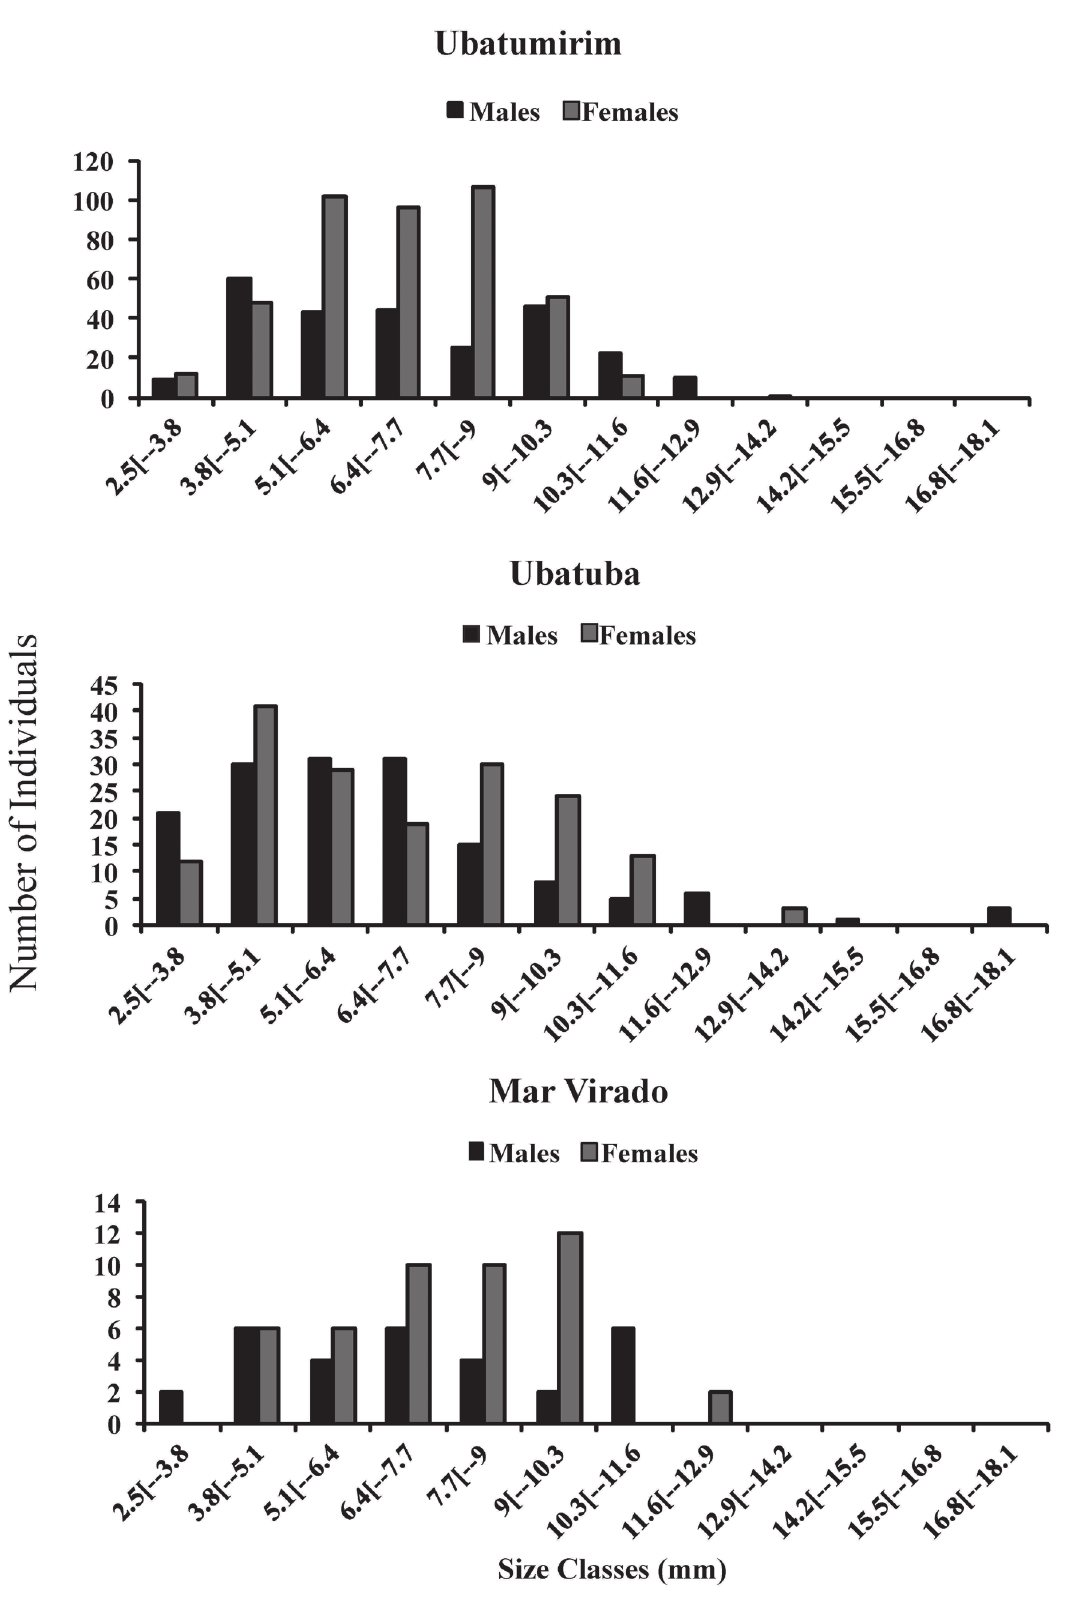
Figure 8. Hexapanopeus paulensis . Frequency distribution of individuals in size classes at the sampled